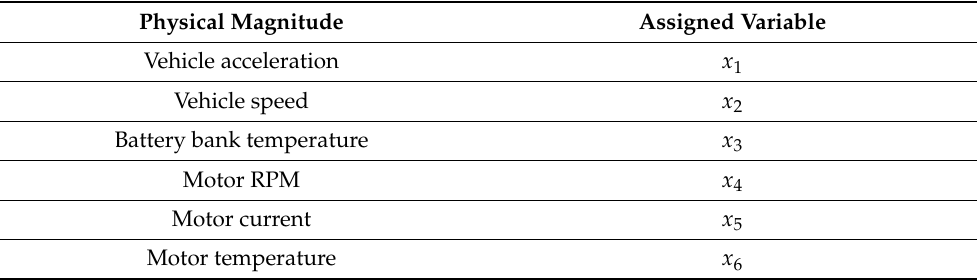
Table 2. Collected data for estimating the SOC